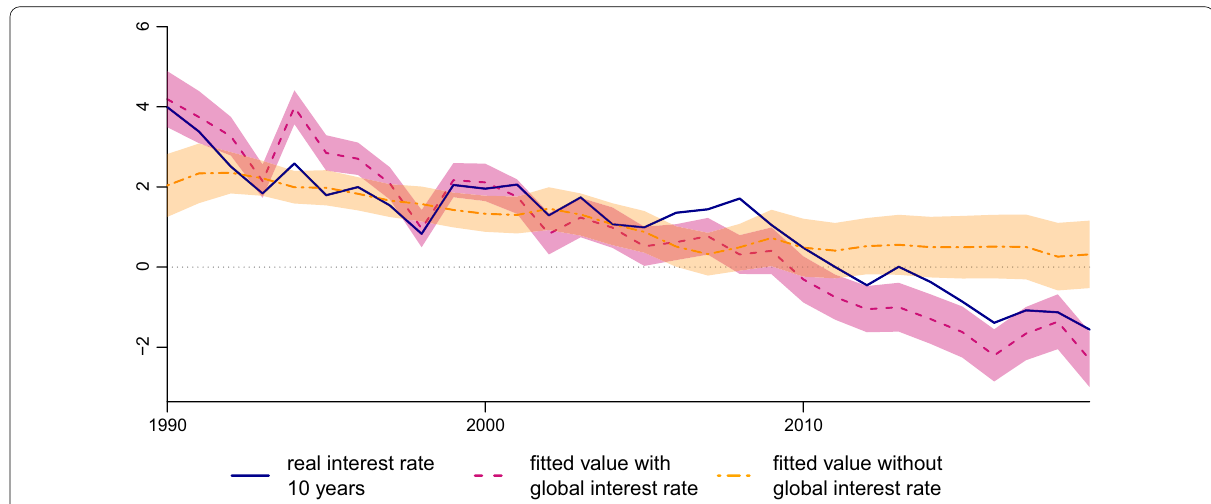
Fig. 4 10‑Year Swiss Real Interest Rate: Actual and Fitted Values. The fitted values and their 95% confidence interval are computed from the regressions in Table 5. Interest rates are in percentage